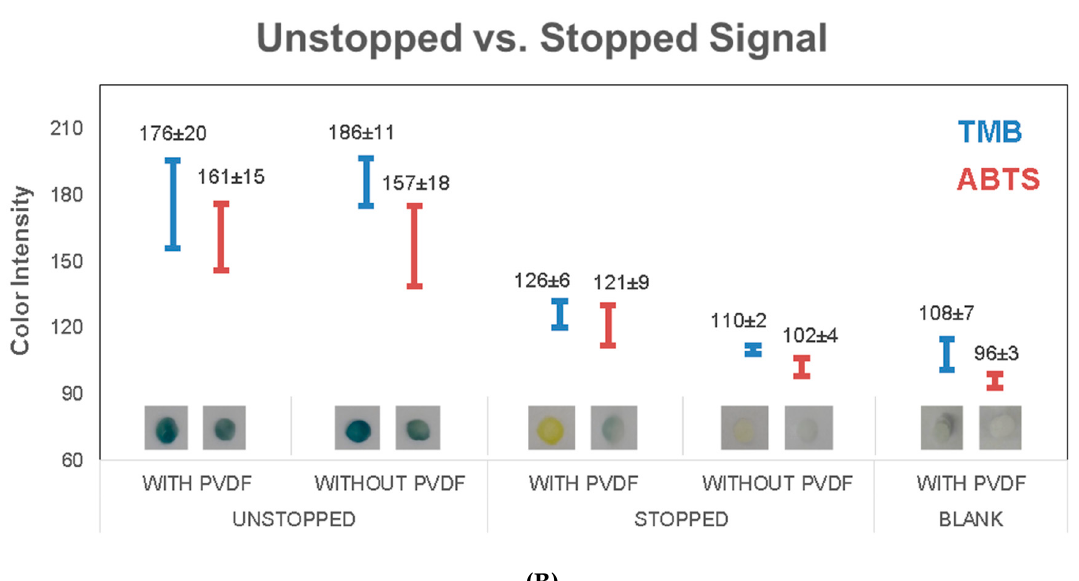
Figure 6. Stopped colorimetric signal on membrane. ( A ) The stopped colorimetric signal was examined with and without three layers of polyvinylidene difluoride (PVDF) membrane as a separation layer between the functionalized substrate and the stopping layers. ( B ) Two substrates were compared: 3,3’,5,5’-tetramethylbenzidine (TMB) vs. 2’-azinobis (3-ethylbenzothiazoline-6-sulfonic acid) (ABTS), for unstopped vs. stopped colorimetric signal comparison on membrane, using 100 ng/mL HRP-antibody.